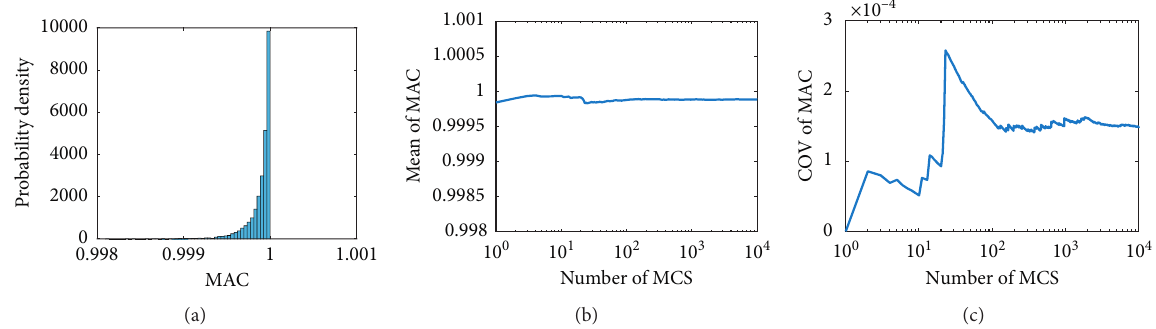
Figure 7: Histogram (a), mean (b), and COV (c) of the first-order MAC based on the 10,000 MCSs.